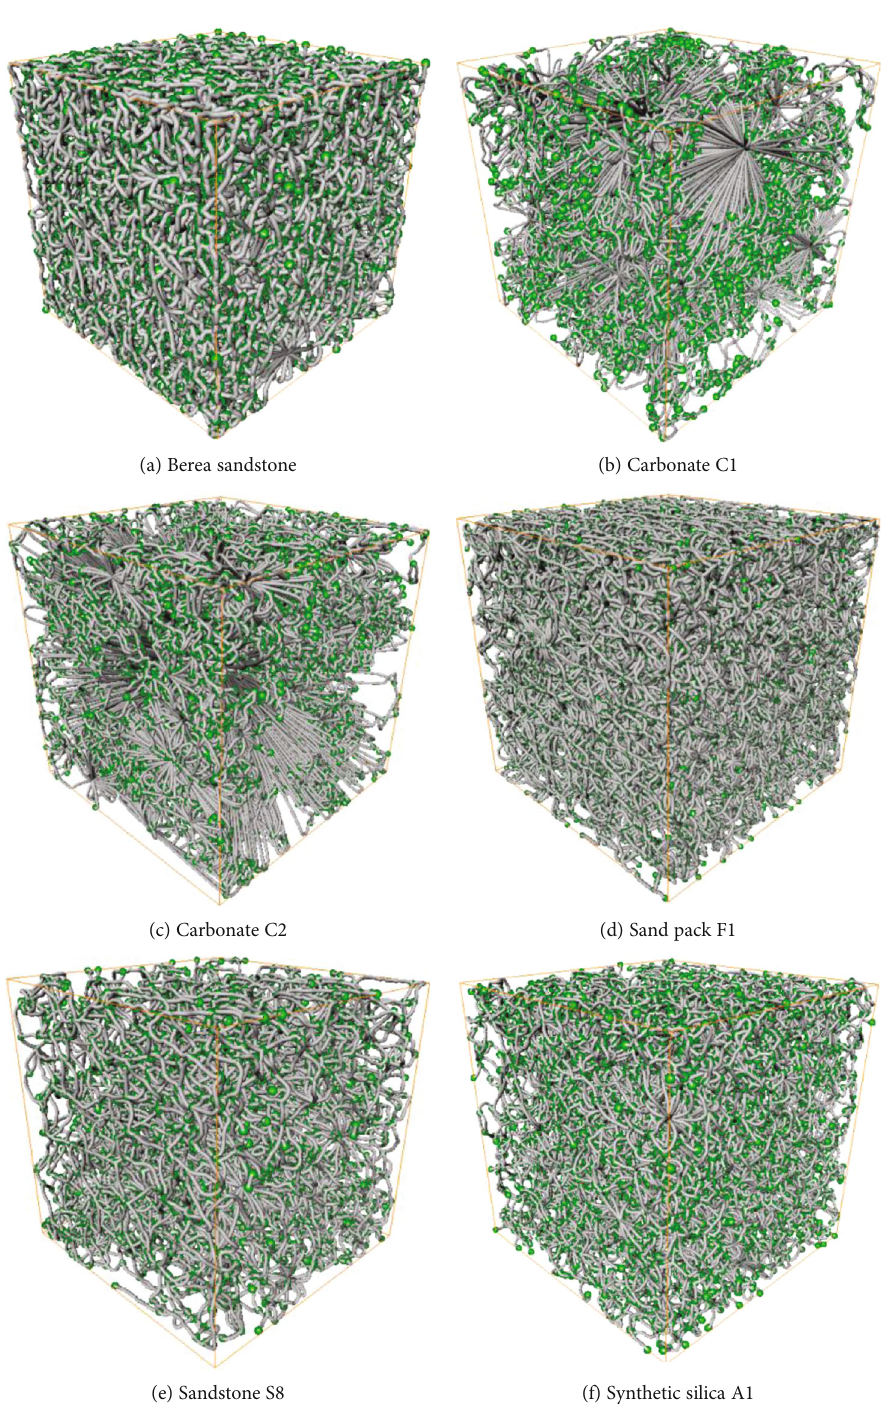
Figure 1: 3D pore network of di ff erent rocks (bounding box volume: 300 μ m by 300 μ m by 300 μ